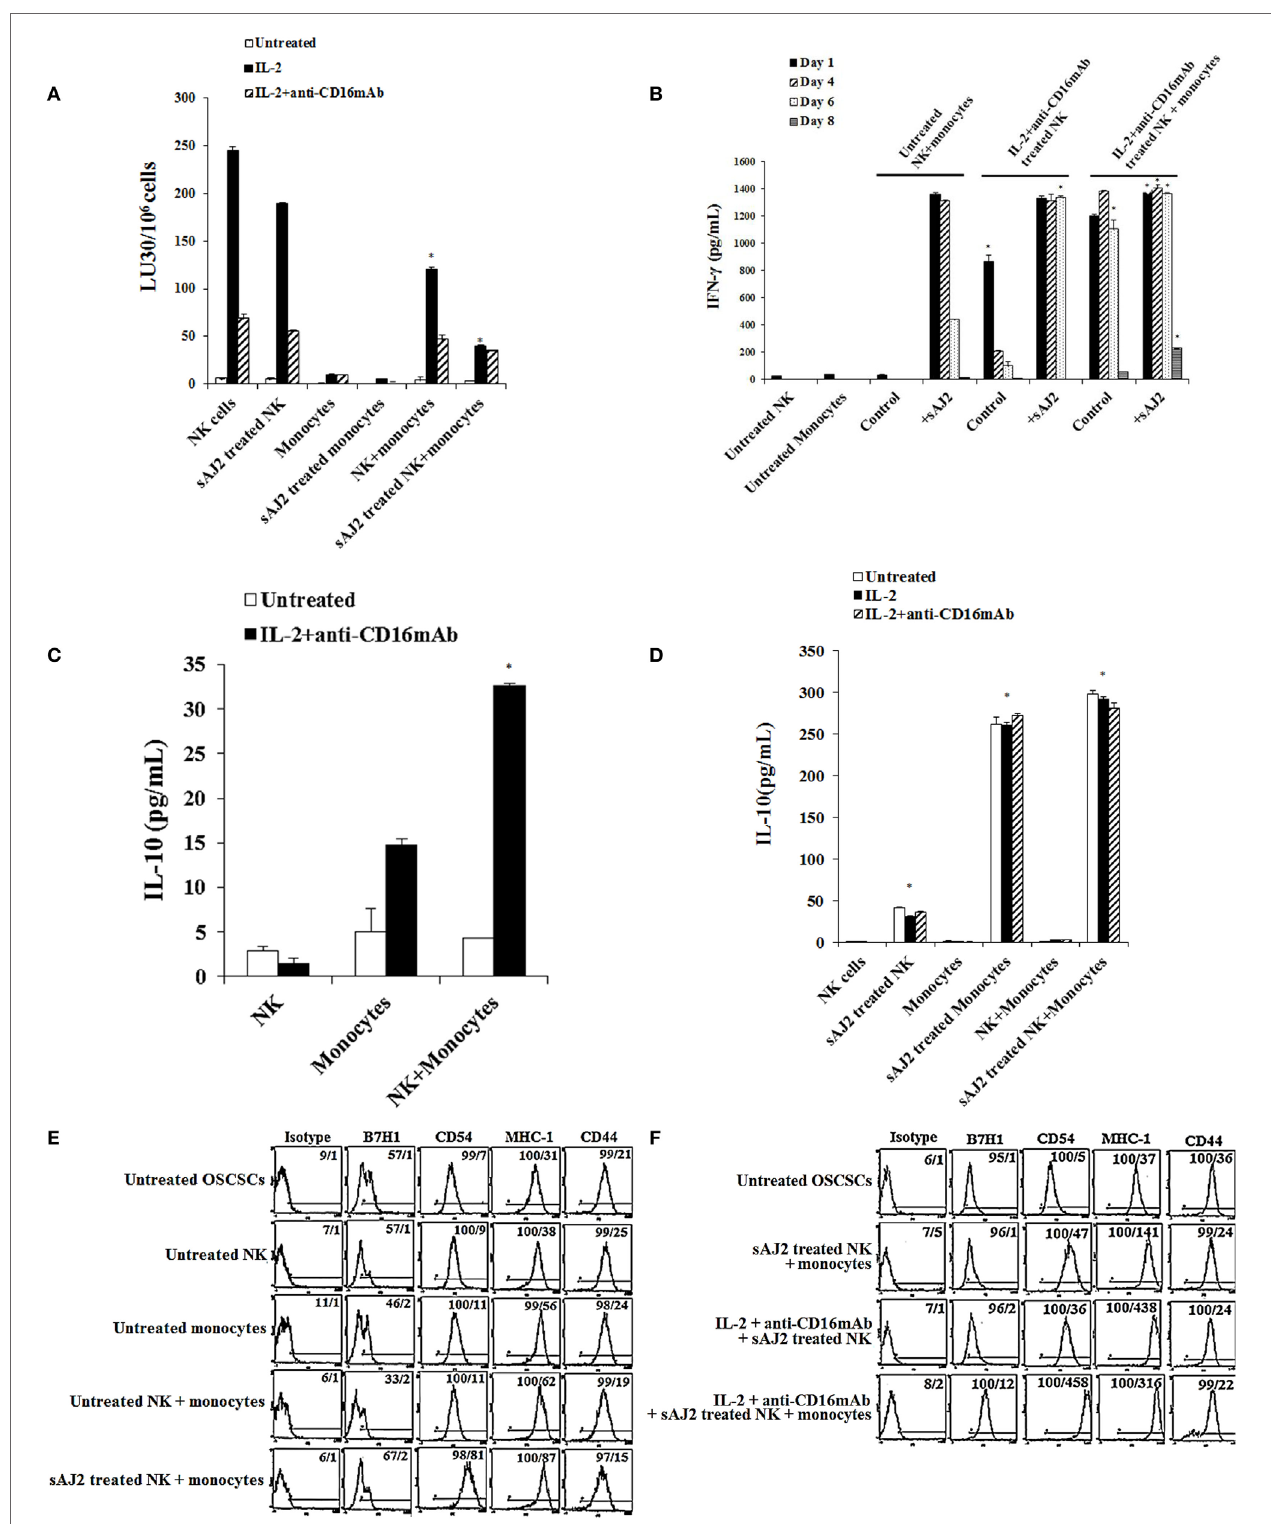
FigUre 4 | Monocytes and probiotic bacteria synergistically induce split anergy in nK cells to increase tumor cell differentiation . Purified NK cells were left untreated, treated with IL-2 (1000U/mL) or a combination of IL-2 (1000U/mL) and anti-CD16mAb (3μg/mL) in the presence or absence of autologous monocytes (1:0.2, NK cell:monocytes) and/or sAJ2 (1:0.5, NK cell:sAJ2) ratios for 18 hours before the supernatants were